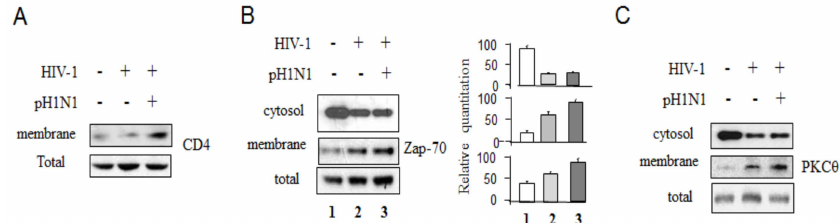
Figure 4. Pandemic influenza A (H1N1) virus infection can induce more CD4 epresiion and activate TCR signaling pathways in HIV-1-infected cells. Jurkat cells were infected with HIV-1 (MN) for 3 days, and then infected with pH1N1, stock A/California/04/2009, and cultured for 3 days. The cells lysates were used to subcellular protein fractionation and Western blot analysis to detect CD4 in plasma membrane ( A ); Zap-70 in cytosol amd plasma membrane ( B ); and PKC 8 in cytosol and membrane ( C ), with their total lysates as